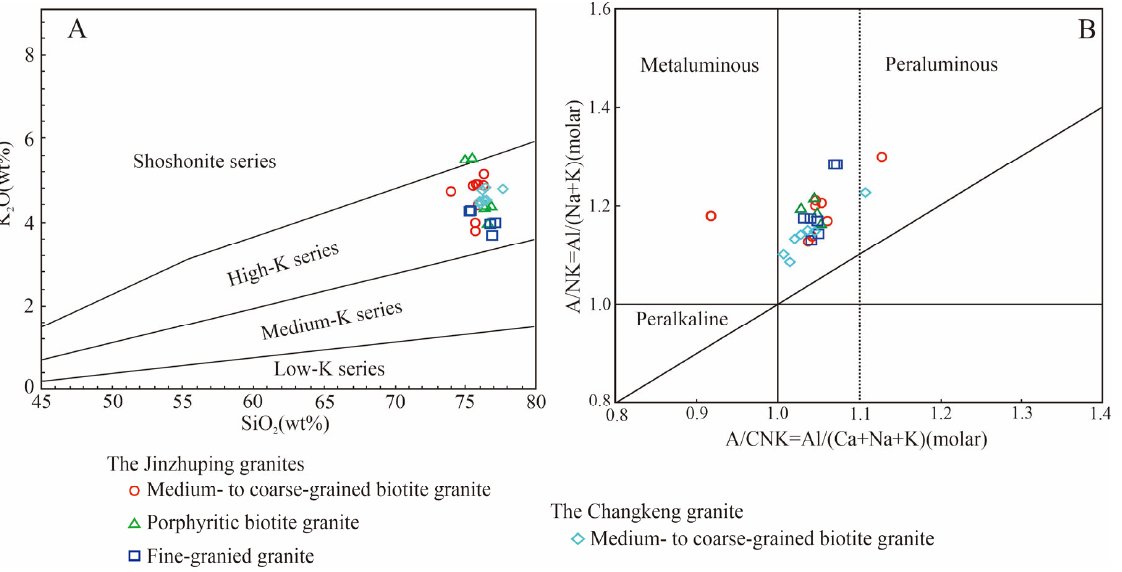
Figure 4. Pl SiO 2 vs. K 2 O diagram ( A ) and A/NK vs. A/CNK diagrams ( B ) of the Helong granities (the compositional fields are from Rollinson [48] and Streckeisen and Le Maitre [49], respectively).